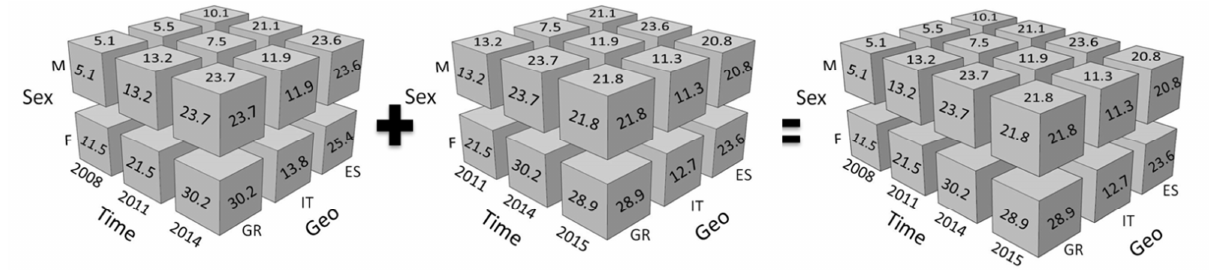
Figure 4: Expanding a Cube with Data from other Cubes